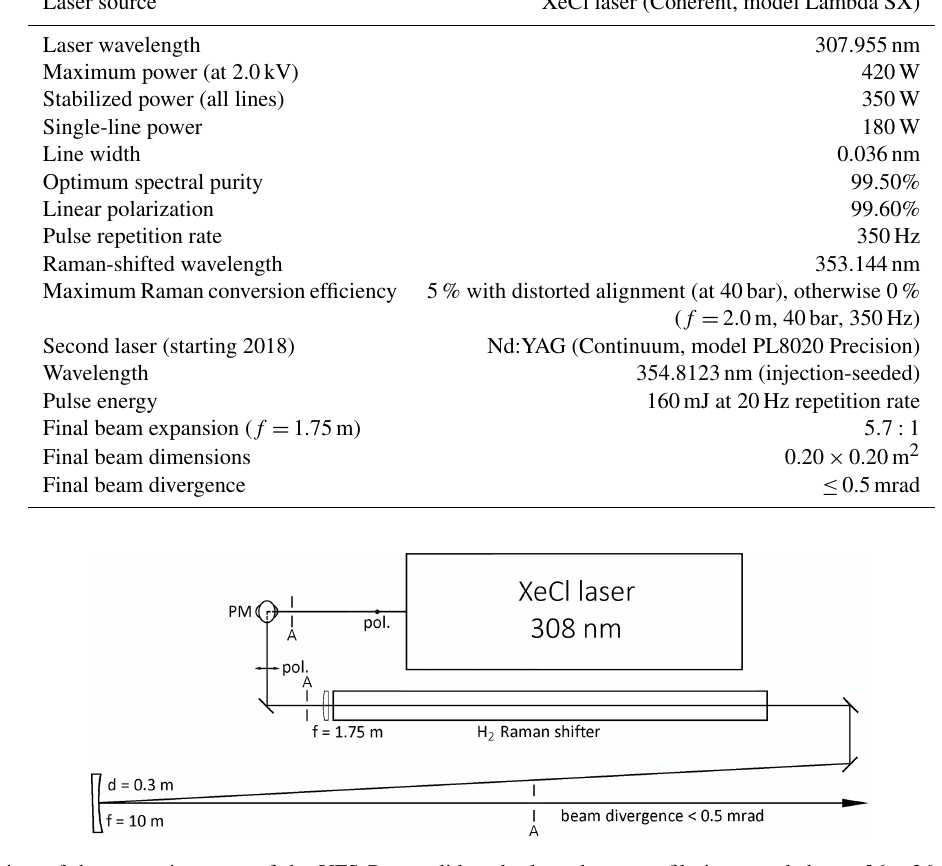
Figure 2. Overview of the transmitter part of the UFS Raman lidar: the laser beam profile is expanded to a 36 × 36mm 2 square shape by a f =− 100mm– f = 250mm pair of cylindrical lenses (recently removed), sent down by a combination of two plane mirrors (rotating the polarization by 90 ◦ ) before it is focussed into a vacuum cell (originally Raman shifter), 3.6m long with a f = 1.75m lens (initially f = 2.0m). The beam diverges from the focal point, is collimated by an f = 10m concave mirror and reaches the motorized beam-steering mirror in a vertical exit shaft outside the laboratory (not shown). Three apertures allow us to control the beam pointing.